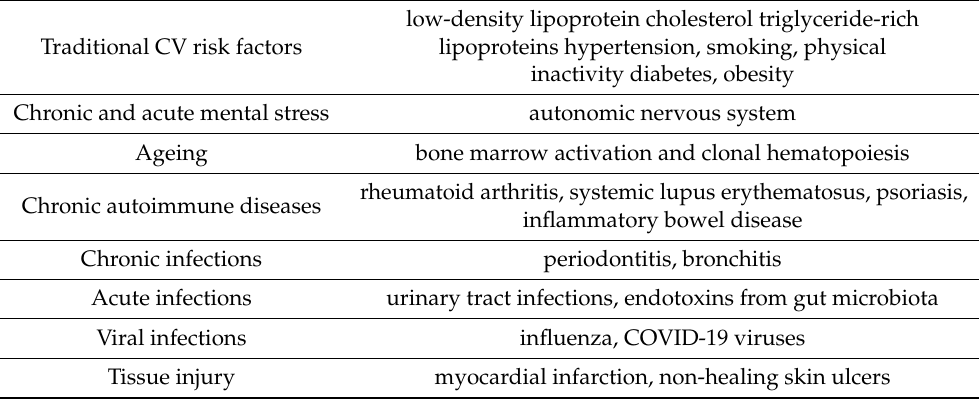
Table 1. Triggers of inflammatory response leading to